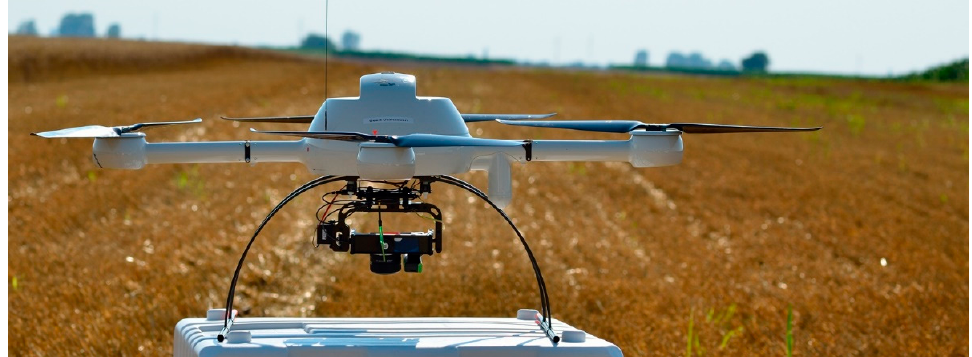
Figure 7. The md4-1000 quadcopter with a Sony NEX-5N mounted in a small carbon fibre camera mount on site. Photo: Geert Verhoeven. Table 1. Overview of some important parameters of all nine UAS sorties.